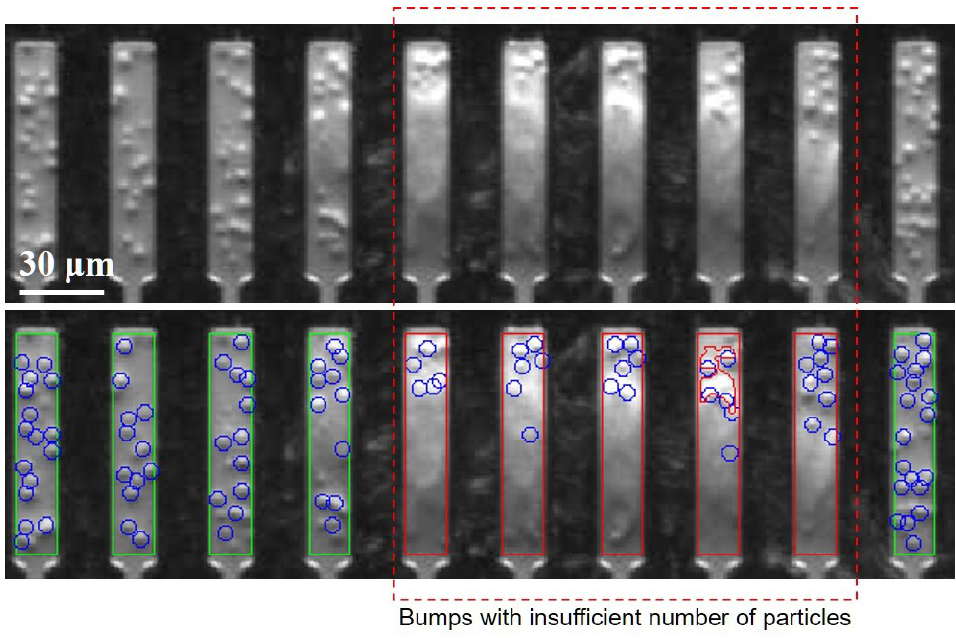
Figure 14. A closer view of the result of particle counts in bar-shape bump areas. The first row is the raw image while the second row is the detection